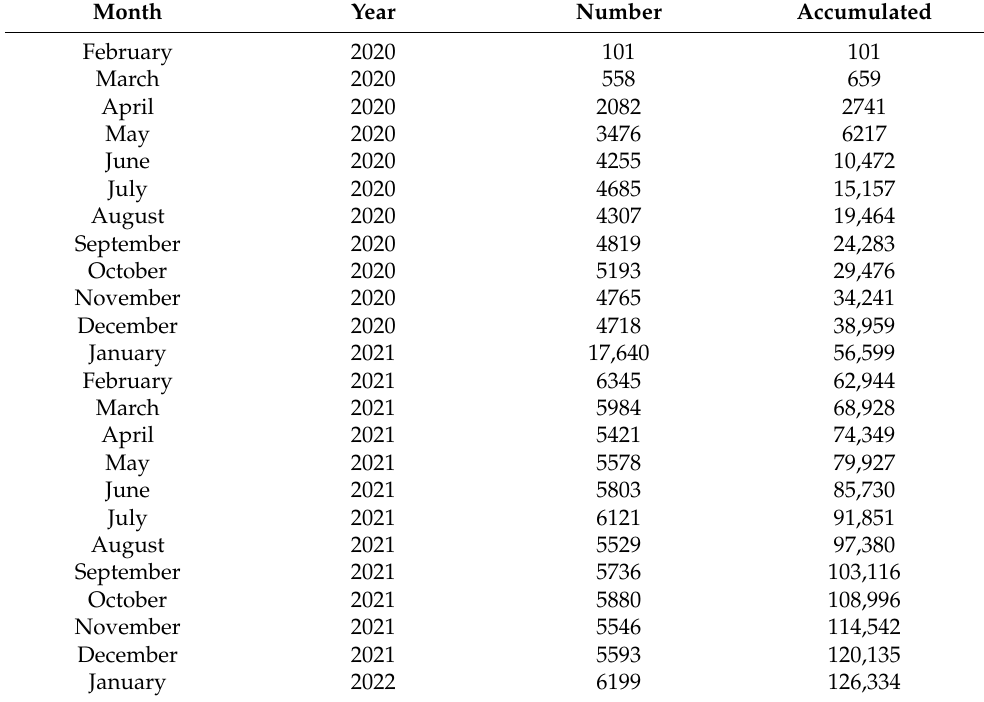
Table 2. Main statistics about the COVID-19 collection.